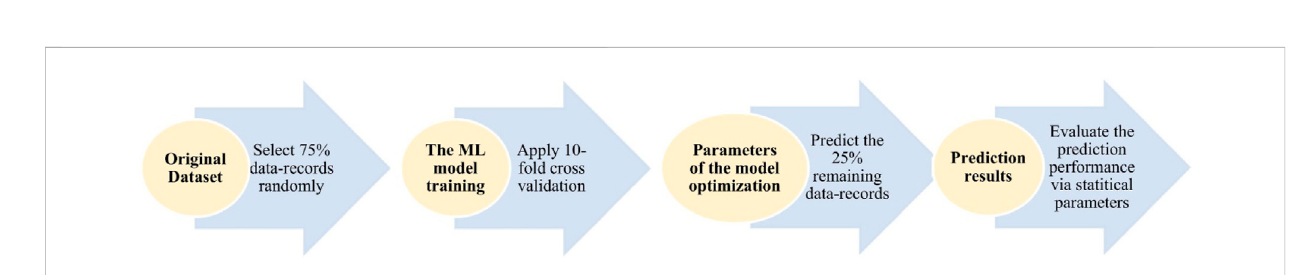
FIGURE 7 The process of training and developing ML models (Cai et al., 2020)